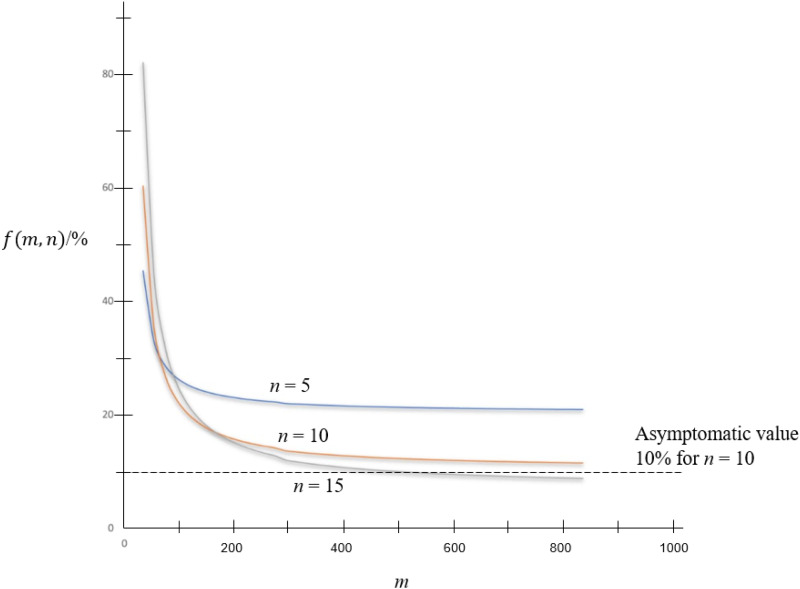
f(m, n) against m.